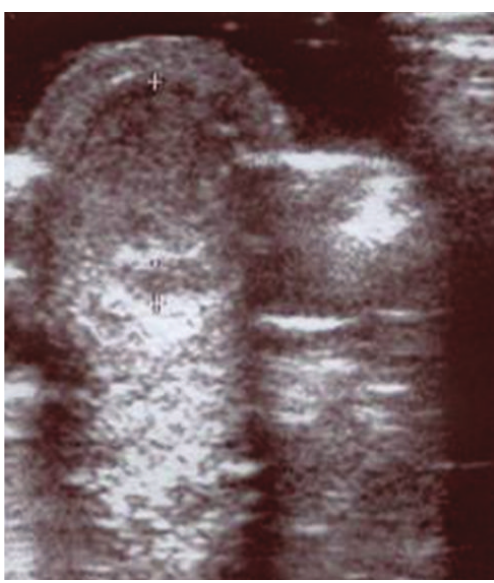
Figure 3: Ultrasound examination showing the presence of the omentum into the hernia.